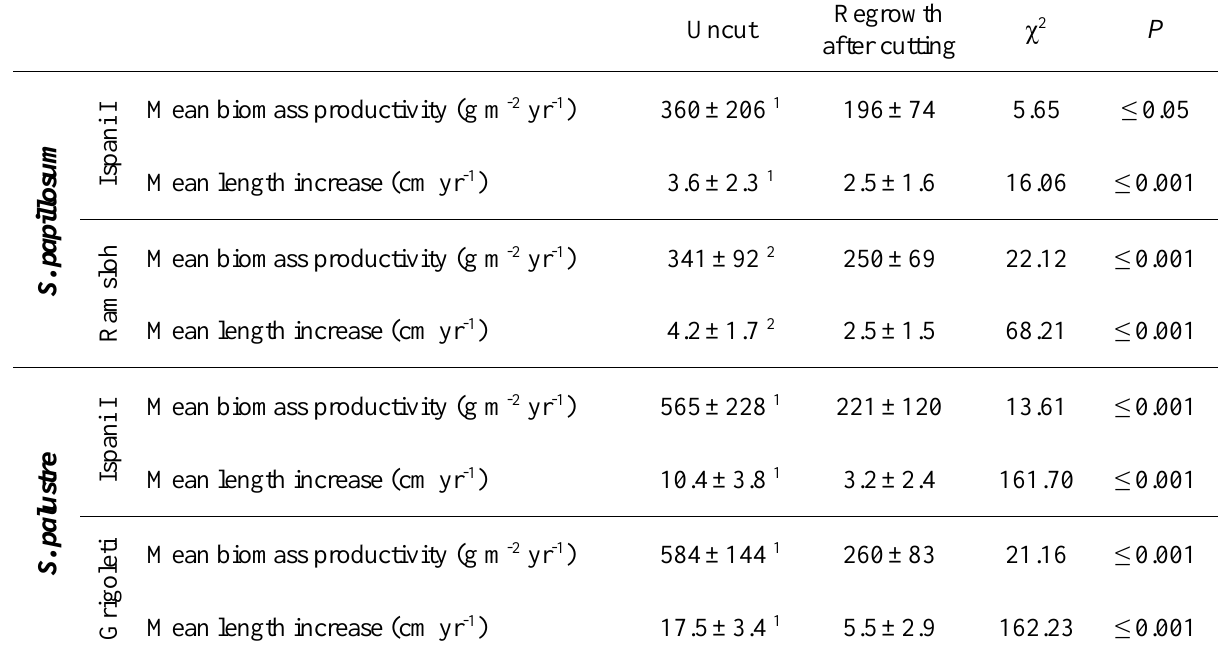
Table 2. Comparison of uncut growth with regrowth after cutting of Sphagnum papillosum over the same periods on the same peatlands (Ispani 1 and Grigoleti in Kolkheti, Georgia; Ramsloh Sphagnum farming field in north-west Germany). Kruskal Wallis test (degrees of freedom =1 for each test), 1 Krebs et al . 2016, 2 Gaudig et al .